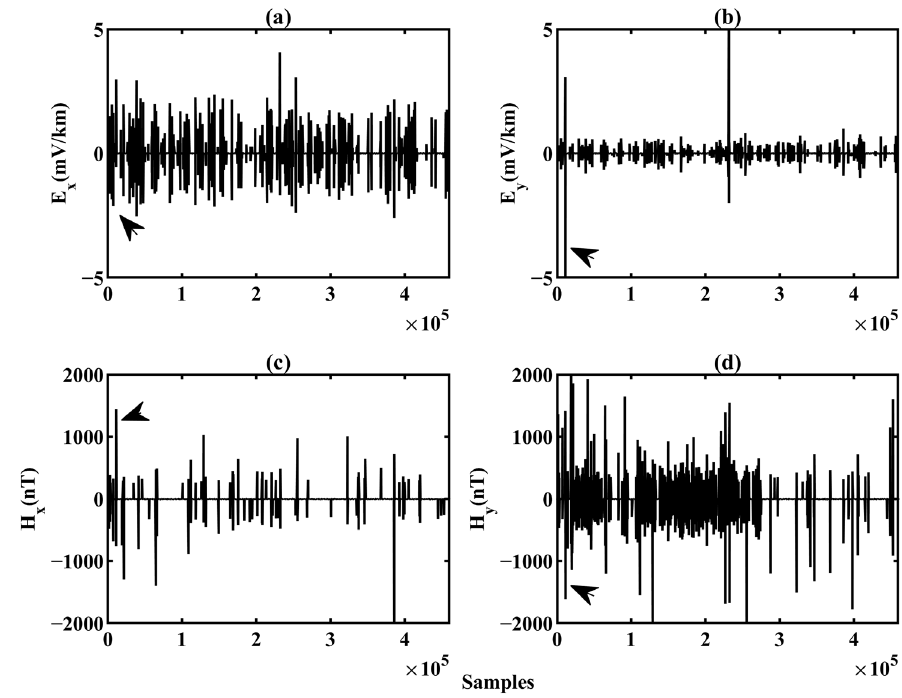
Figure 6. The 5th test dataset. ( a ) e x , ( b ) e y , ( c ) h x , and ( d ) h y time series.